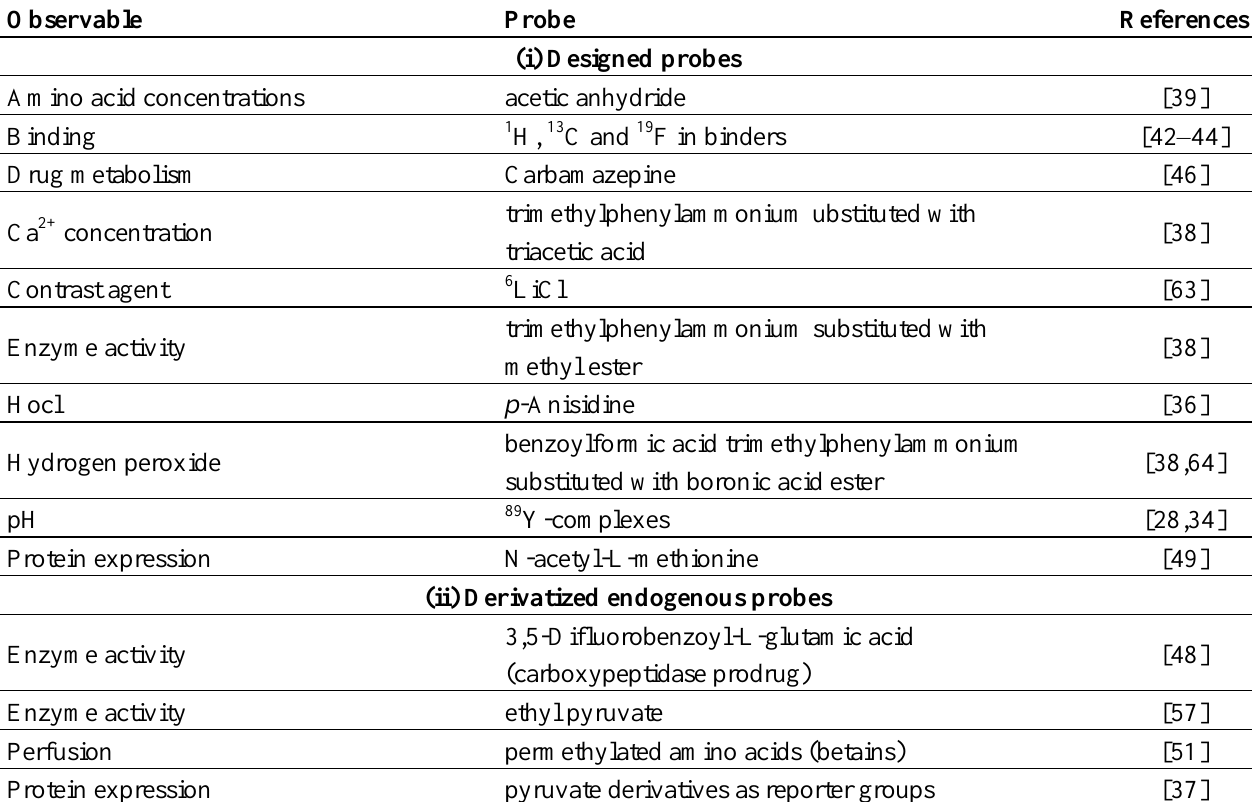
Table 2. Examples of hyperpolarized NMR